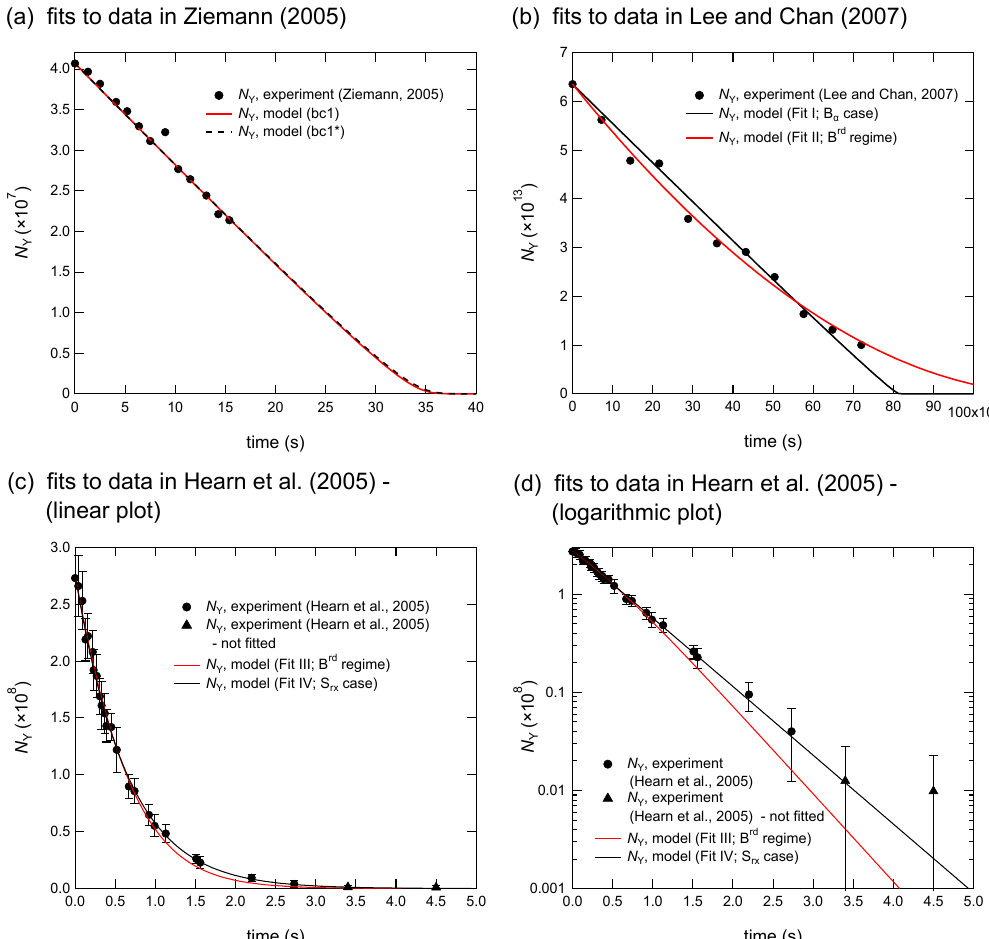
Fig. 6. Comparison of experimental and modelled data of various limiting cases, using time invariant kinetic parameters. In (a) the two parameter sets bc1 and bc1 ∗ lead to the same correlation with the experimental data and show the appropriate linear decay. In (b) , data from Lee and Chan (2007) show another mostly linear decay of bulk material. This can be realised with two KM-SUB parameter sets similar to bc1 ∗ showing B α and B rd behaviour, respectively. In (c) , data from Hearn et al. (2005) show a nonlinear decay that thus can not be described by accommodation-limited cases. The B rd and S rx fits shown are in excellent agreement with the experimental data. (d) reveals in a logarithmic representation that the quality of Fit III is lower after ∼ 2s and 85% of the reaction. The last two points of this dataset (black triangles) were excluded from the fit as their value is not significantly different from